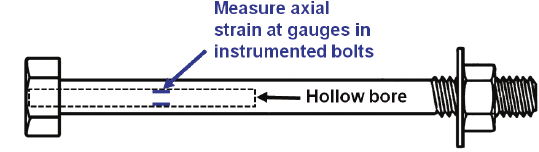
Fig. 9. Schematic of strain gauge placement, static tension test.